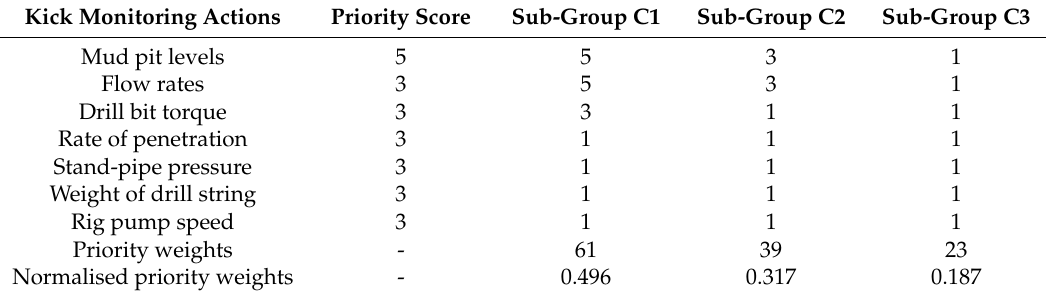
Table 7. Case study: Evaluation of first relationship matrix.